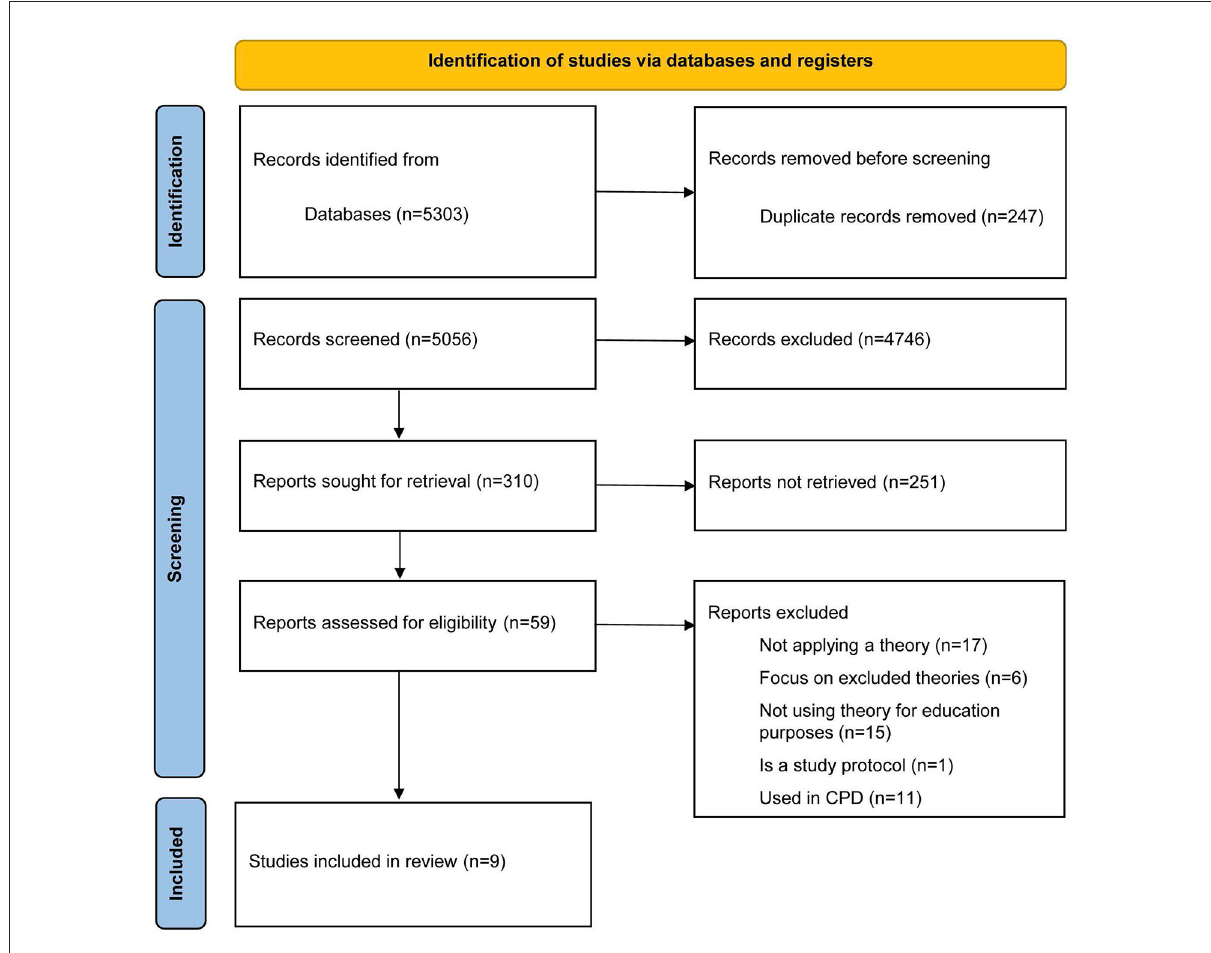
FIGURE1 Prisma flow